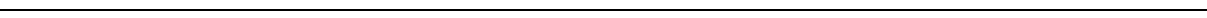
Fig. 6 ESC-mediated target cell invasion contributes to teratoma growth. a Outline of the experiments in b – g . b Incidence of teratoma formation upon injection of IGF-I- or IGF-II-depleted ESCs. Matrigel-injected mice were co-analysed as controls. #, non-detectable ( n = 4; mean ± s.d.). c Teratoma weight upon injection of IGF-I- or IGF-II-depleted ESCs. Representative pictures show ESC-injected hind limbs 8 weeks after implantation. Data are presented as the fold change of the non-targeting control (si-control) ( n ≥ 3; mean ± s.d.). d Immunoblot of tissue lysates from ESC-si-control- or ESC-si-IGF-injected mice for the detection of phosphorylated S6 and MMP14. The absence of human cells from non-teratoma tissues and equal loading was veri fi ed by detection of human CDK4 and Ponceau-S staining. IMR-90 lysate was co-analysed as a positive control for the detection with human-speci fi c antibodies. e Gelatin zymography of tissue lysates from ESC-si-control- or ESC-si-IGF-injected mice for the detection of MMPs. The gel pictures were colour-inverted. f Immunostaining of teratoma tissues from ESC-si-control- or ESC-si-IGF-injected mice for the detection of mouse cyclophilin A. Nuclei were counterstained with DAPI. The dotted line in the ʽ T (edge) ’ panel delineates the border between adjacent and teratoma (T) tissue. Scale bar , 50 μ m. g Quanti fi cation of cyclophilin A-positive cells in teratomas from ESC-si-control- or ESC-si-IGF-injected mice. Data are based on immunostainings as shown in f and are presented as the fold change of the non-targeting control (si-control) ( n ≥ 6; mean ± s.d.). * P < 0.05; **** P < 0.0001; ns, P > 0.05 (not signi fi cant) by unpaired, two-tailed Student ’ s t -test analysis. n refers to biological